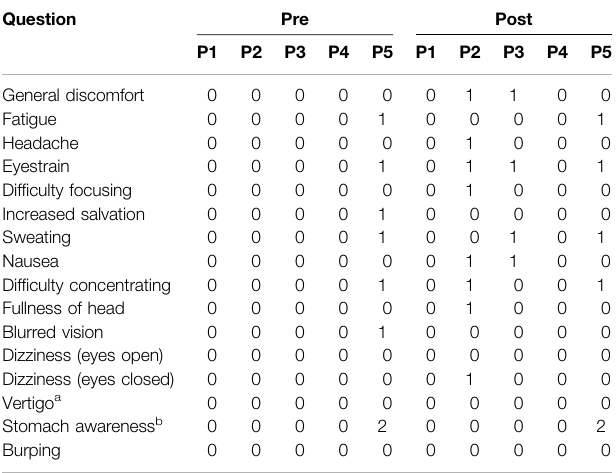
TABLE 6 | Results from the simulator sickness questionnaire. Question